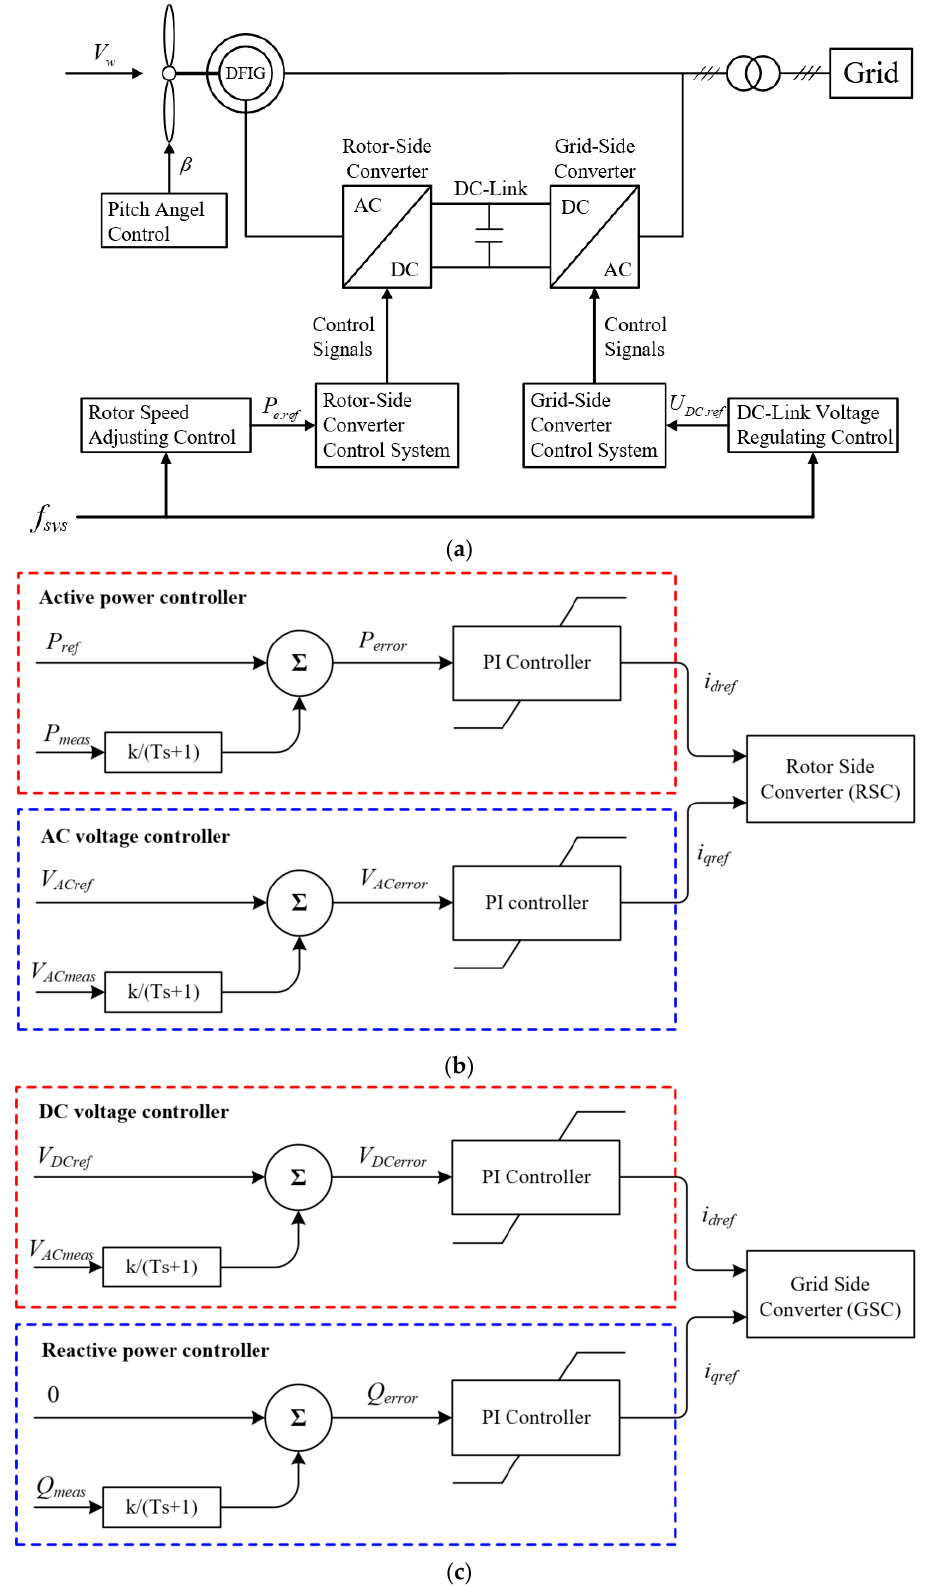
Figure 1. Diagram configuration and control of the DFIG: ( a ) Diagram configuration of a DFIG; ( b ) RSC controller; ( c ) GSC